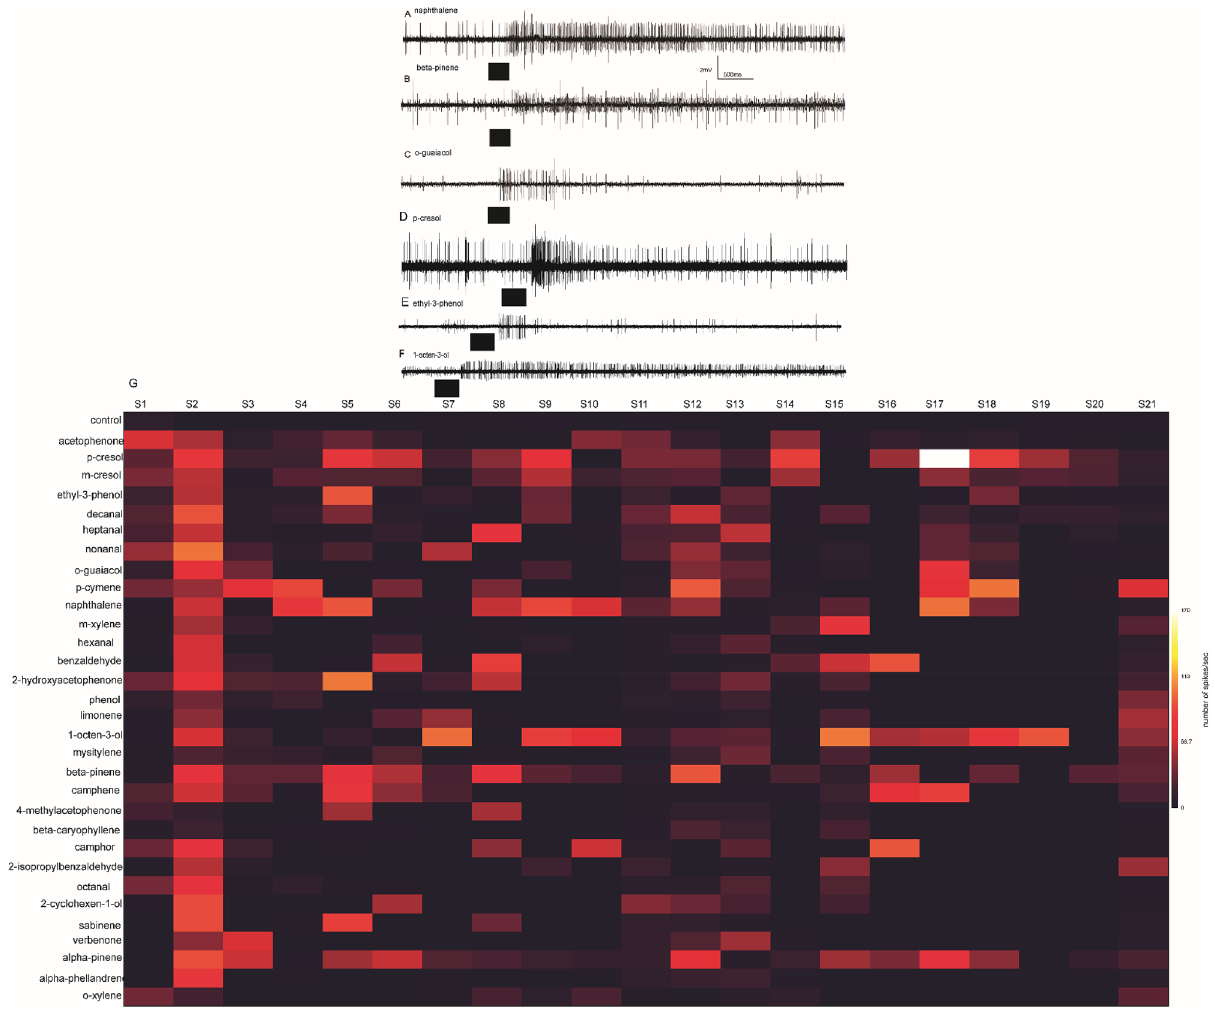
Figure 3. Olfactory coding of camel derived volatile chemicals . ( A – F ) show representative traces of OSNs of S. calcitrans response to naphthalene, β-pinene, guiacol, p-cresol, ethyl-3-phenol, and 1-octen-3-ol, respectively. Black box indicates 500 ms odour stimulation . ( G ) Shows the matrix coding based on the number spikes/sec elicited by 21 sensilla to the 31 camel derived compounds (left) and